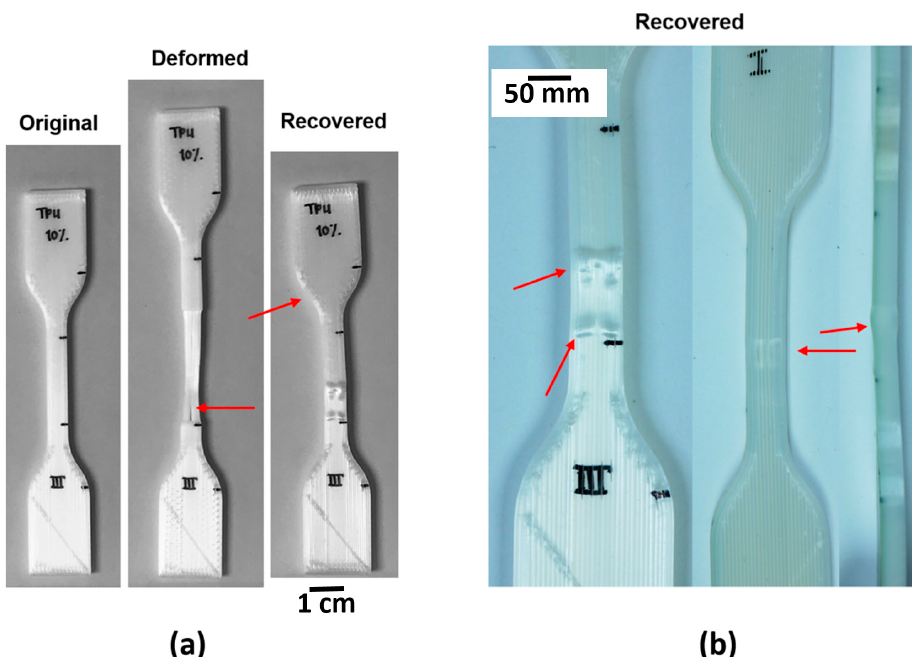
Figure 13. Examples of damage and distortion that occurred ( a ) during the deformation and recovery process. ( b ) Higher magnification image depicting the damage that was observed after the recovery process. In this case, the images are of PLA:TPU FFF-manufactured in a 90° raster pattern. Table 4. Shape memory property values for the material systems that were subjected to a defor- mation/recovery cycle.